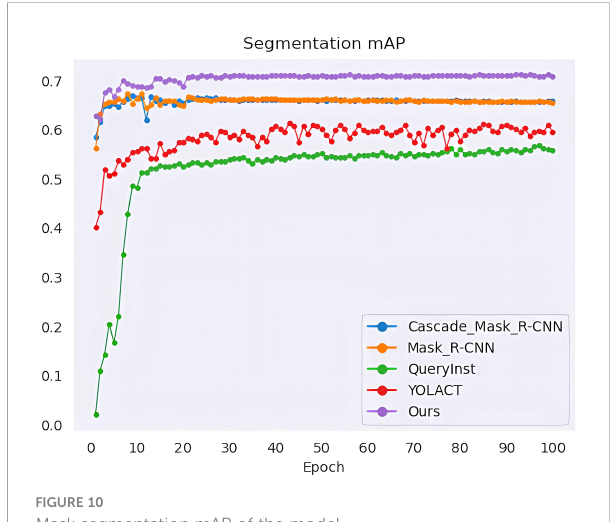
FIGURE 10 Mask segmentation mAP of the model.